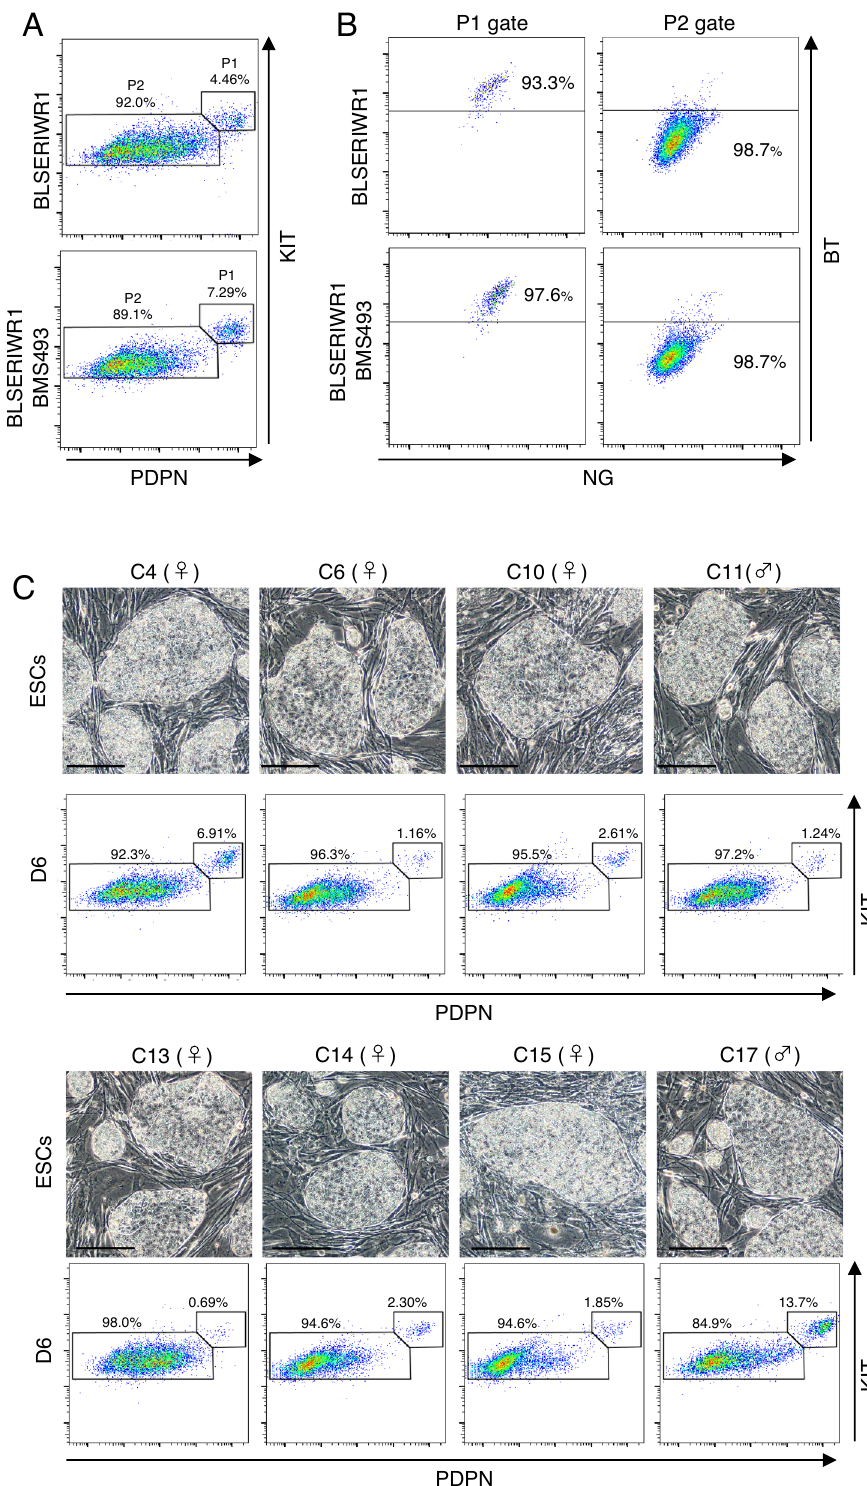
Figure 6. Induction and isolation of cjPGCLCs from non-reporter cjESC lines. ( A ) Isolation of non-reporter cjPGCLCs with surface marker proteins. FACS plots show the expression of PDPN and KIT in cells at day 6 of culture under a BLSE + IWR1 or BLSE + IWR1 + BMS condition. Note that a separable cell population was observed in the double-positive fraction. ( B ) Validation of cells double-positive for PDPN and KIT. FACS plots show BTNG expression in the cell populations gated in P1 and P2, as shown in ( A ). Note that more than 90% of cells double-positive for PDPN and KIT are positive for BTNG. ( C ) Induction of cjPGCLCs from multiple cjESC lines. The images show the morphology of each cjESC line cultured on MEF in PESFA. FACS plots below the images show the expression of PDPN and KIT in cells at day 6 of culture under the BLSE + IWR1 + BMS condition. Scale bar, 200